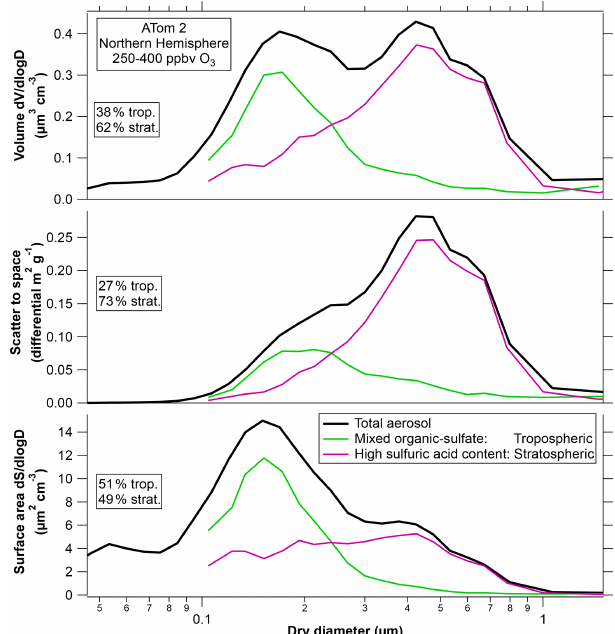
Figure 8. The composition-resolved size distribution from Fig. 1 for the ATom2 Northern Hemisphere weighted by volume, light scat- tered to outer space, and surface area. The two sulfuric acid cat- egories (with and without meteoric metals) have been combined. Percentages refer to sizes above 0.1µm only. ATom2 is chosen as an example; Fig. S4 shows the percentage contributions of various particle types to these processes for other deployments and for the Southern Hemisphere. Scaling to net thermal infrared heating gives relative contributions nearly identical to volume in the top panel. Scaling to sedimentation rate gives a similar shape to the middle